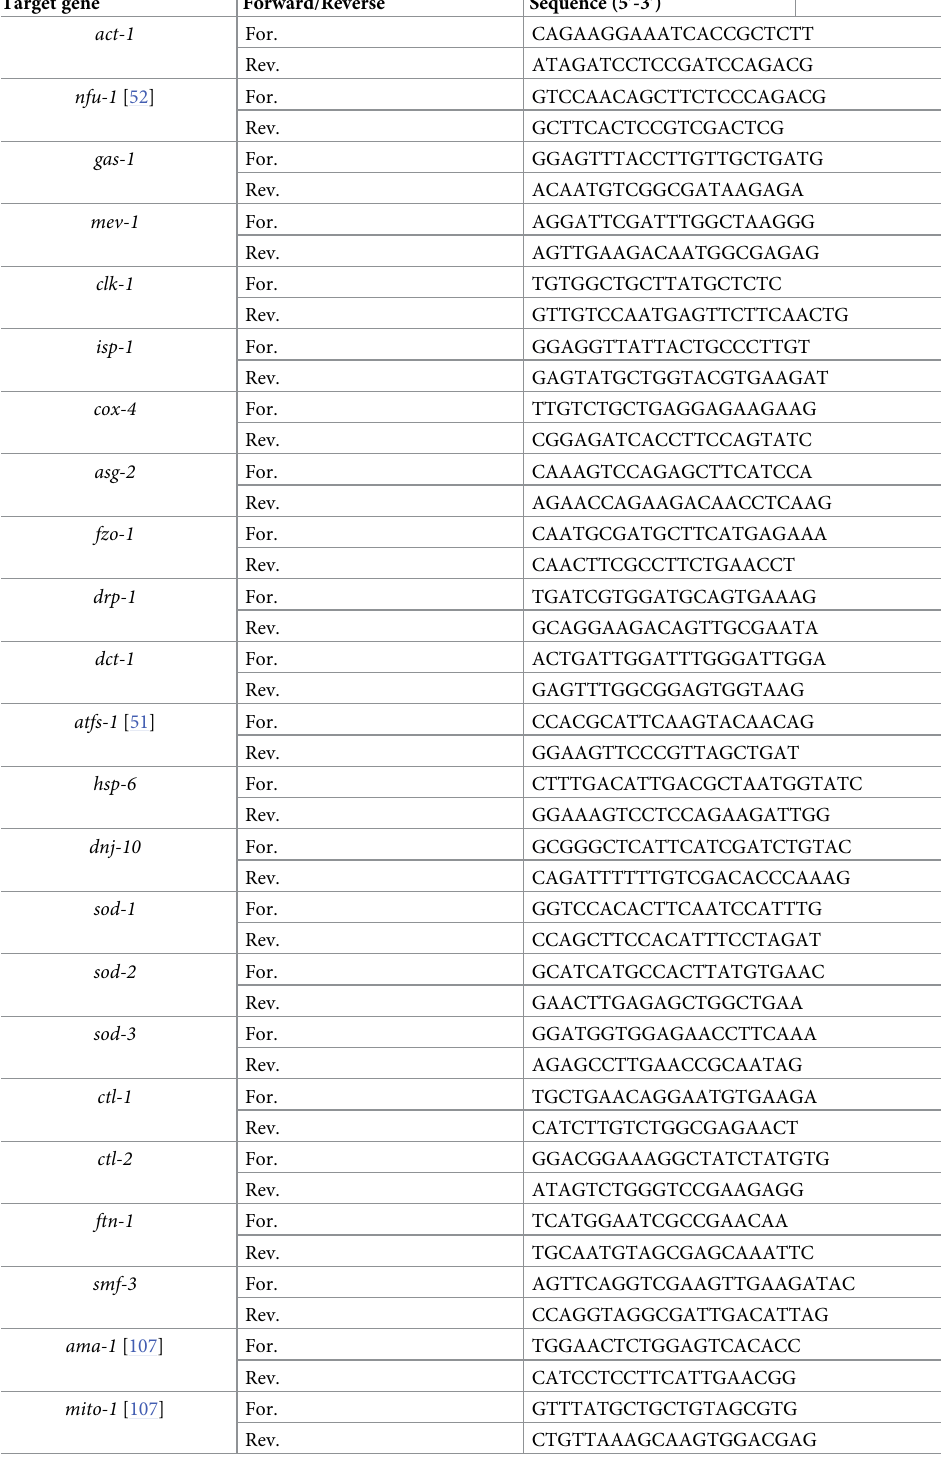
Table 6. Primers used in this study. Forward and reverse primers indicated. All sequences oriented 5’ to